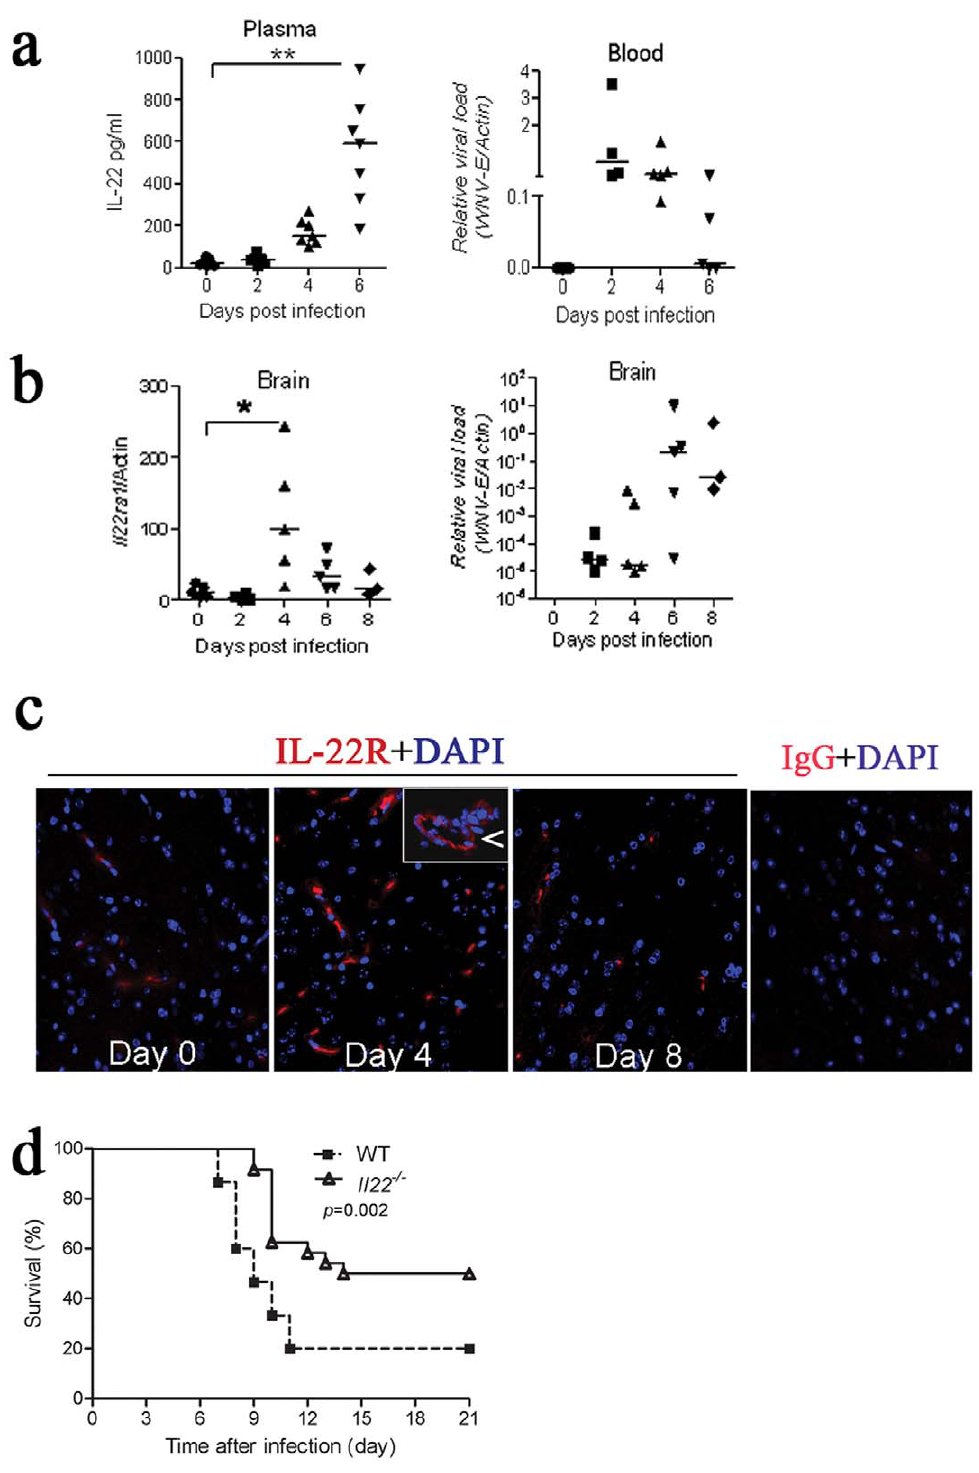
Figure 1. Il22 2 / 2 mice are resistant to lethal WNV infection. a ) Plasma IL-22 levels of WT mice were measured by ELISA, and viremia was quantified by q-PCR using WNV envelope gene ( WNV-E ) primers and probes and normalized with mouse actin. b ) IL-22R a 1 transcripts in the WT mouse brain were examined by q-PCR and normalized with actin, and viral loads were quantified by q-PCR for WNV-E and normalized with mouse actin; * p , 0.05; ** p , 0.01. Each dot represents one mouse. c ) Immunofluorescence microscopy of IL-22R a 1 (red signal) in the WT mouse brain (cerebral cortex is shown). DAPI nuclear counter-stain is shown in blue. Arrows indicate blood vessels, shown in higher-magnification insets. d ) Survival curve of Il22 2 / 2 vs . WT mice challenged with WNV. Mice were infected with 200 PFU of WNV via s.c. footpad injection and monitored daily for survival for 21 days (n=30 for WT and n=24 for Il22 2 / 2 mice). Data are pooled from 3 independent experiments.